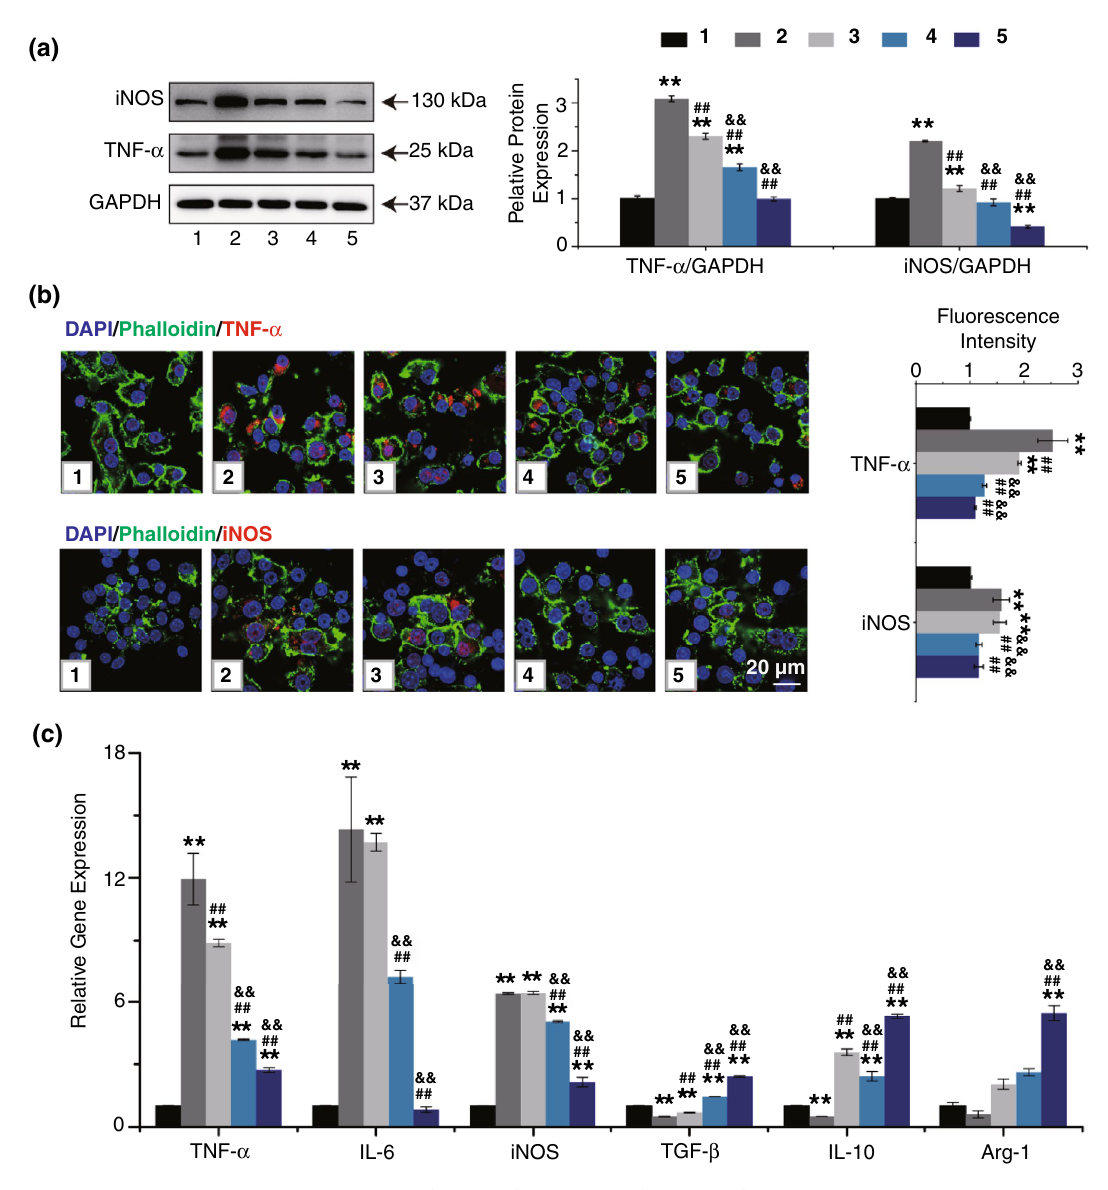
Fig. 5 tFNAs-RSV inhibits M1 polarization and induces M2 polarization in vitro. a Western blot and quantitative analysis of TNF-α and iNOS expression in LPS and IFN-γ stimulated RAW264.7 cells with different treatments; b Immunofluorescence images and quantitative analysis of TNF-α and iNOS expression in cells after different treatments. Scale bar: 20 μm; d Quantitative RT-PCR analysis of the expression of TNF-α , IL-6 , iNOS , TGF-β , IL-10 , and Arg-1 . Data are performed using one-way analysis of variance (ANOVA) and presented as mean ± SD ( n ≥ 3). Statistical analysis: * Compare with the control group, * P < 0.05, ** P < 0.01; # Compare with the LPS and IFN-γ group, # P < 0.05, ## P < 0.01; & Compare with the control group, & P < 0.05, && P <